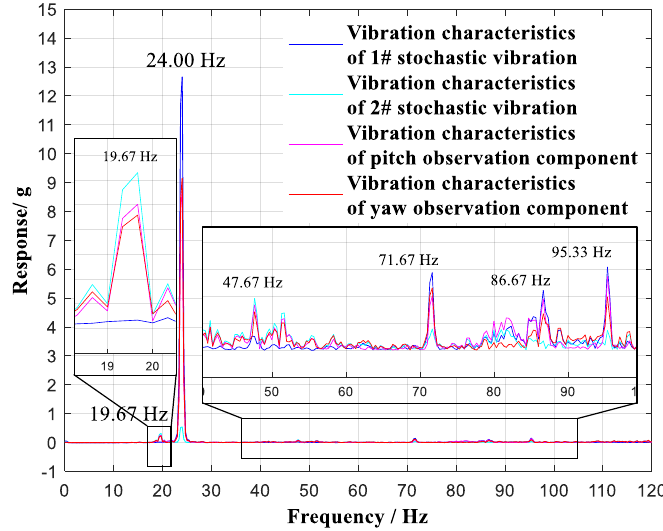
Figure 15. Comparison of vibration characteristics with continuous lifting (γ = 0°) of the aircraft model at Ma = 0.7.